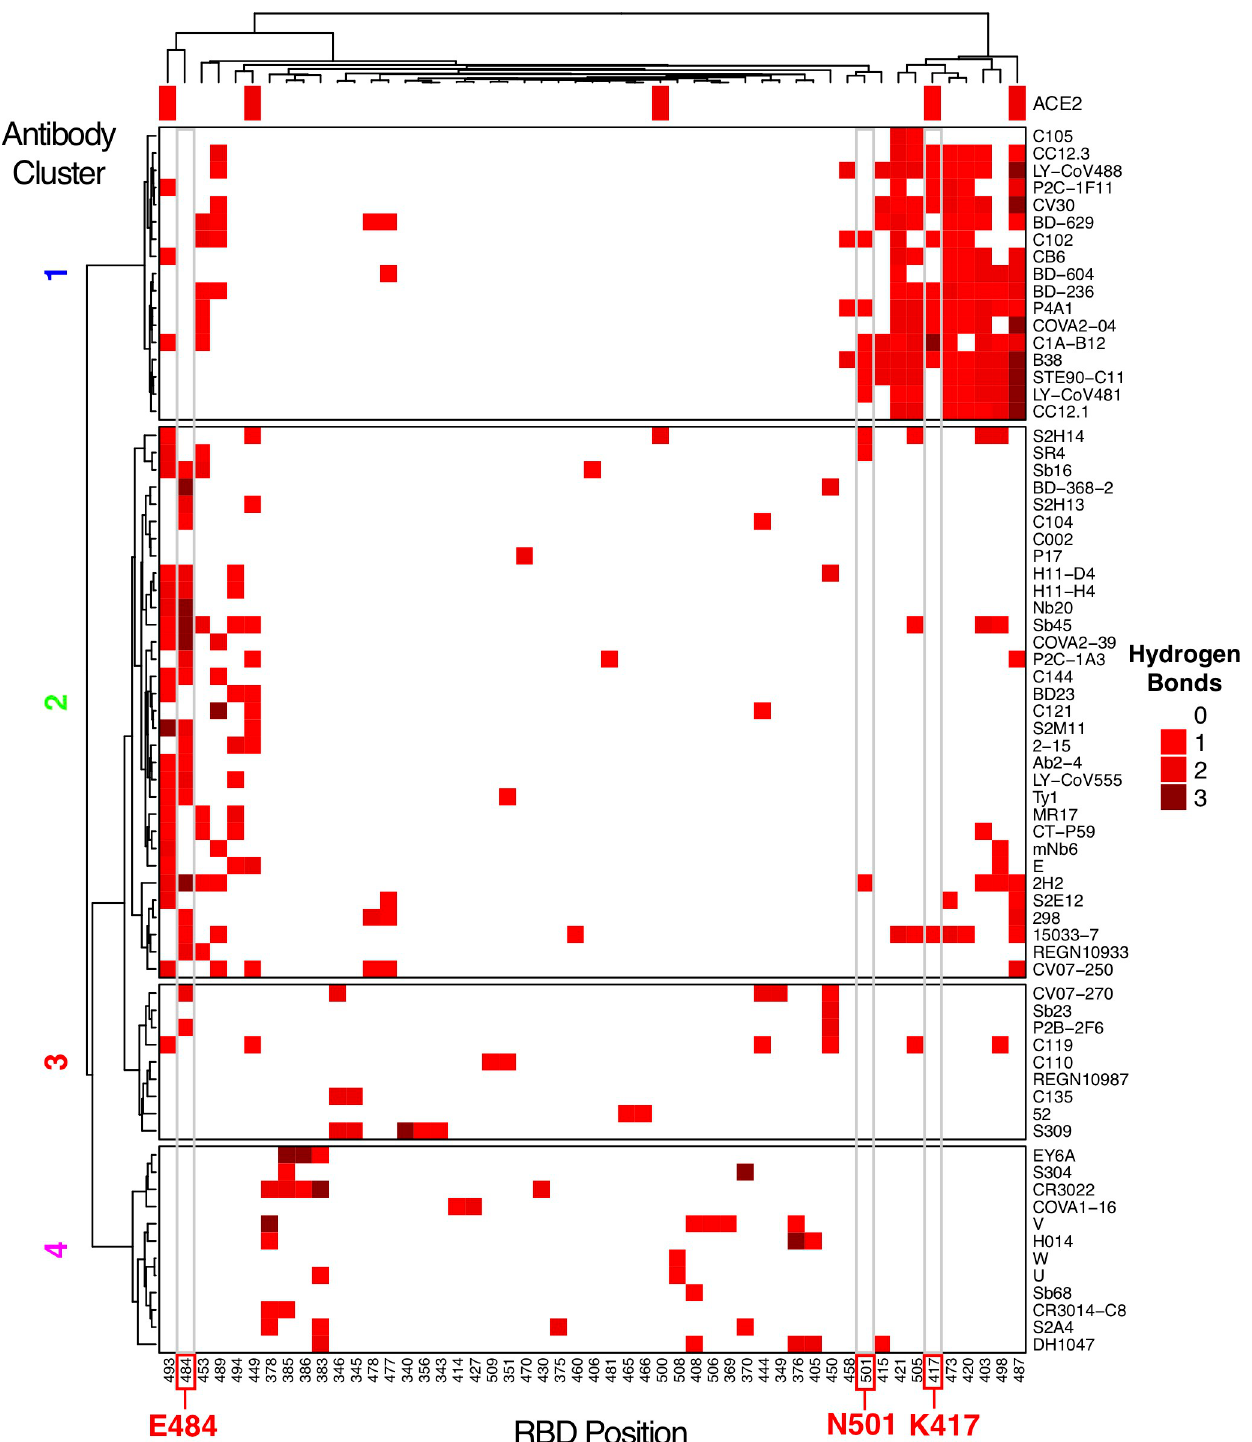
Fig 4. RBD hydrogen bond contacts of SARS-CoV-2 antibodies. Hydrogen bonds to RBD residue side chains were calculated for all antibody-RBD complexes using the hbplus program [51]. Each hydrogen bond contact is colored by number of hydrogen bond interactions, as indicated on the key, and RBD positions are ordered by hierarchical clustering based on hydrogen bond profile similarities, with corresponding dendrogram shown at top. Antibodies (rows) are ordered and clustered as in Fig 2 , based on the RBD contact profile similarities, and RBD hydrogen bond contacts with ACE2 (PDB code 6LZG) are shown in the top bar. RBD residues that are mutated in SARS-CoV-2 variants of concern (K417, E484, N501) are labeled at bottom and highlighted with gray boxes in heatmap.